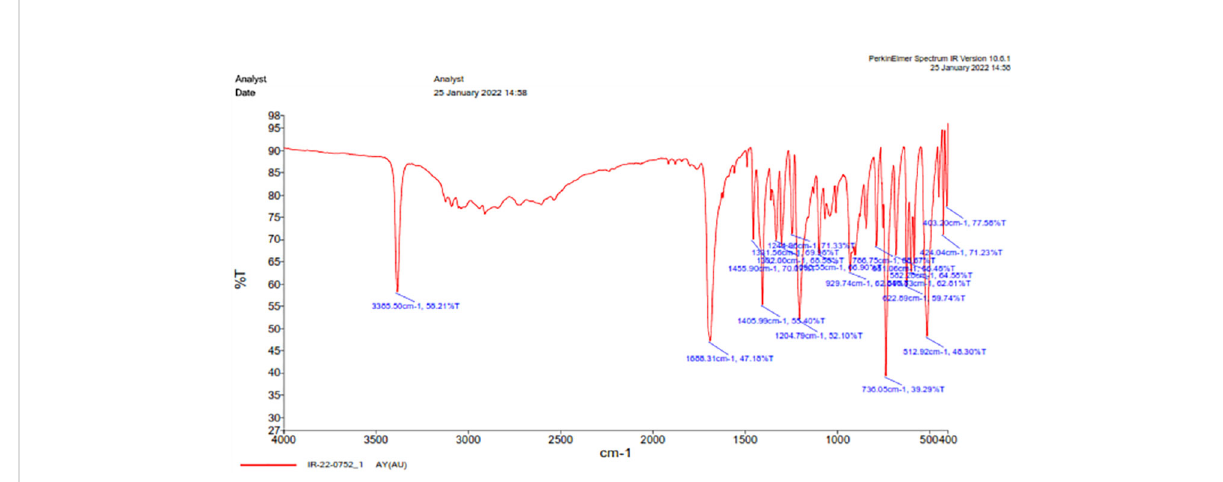
FIGURE 6 Functional analysis using FT-IR of IAA produced by Microbacterium testaceum